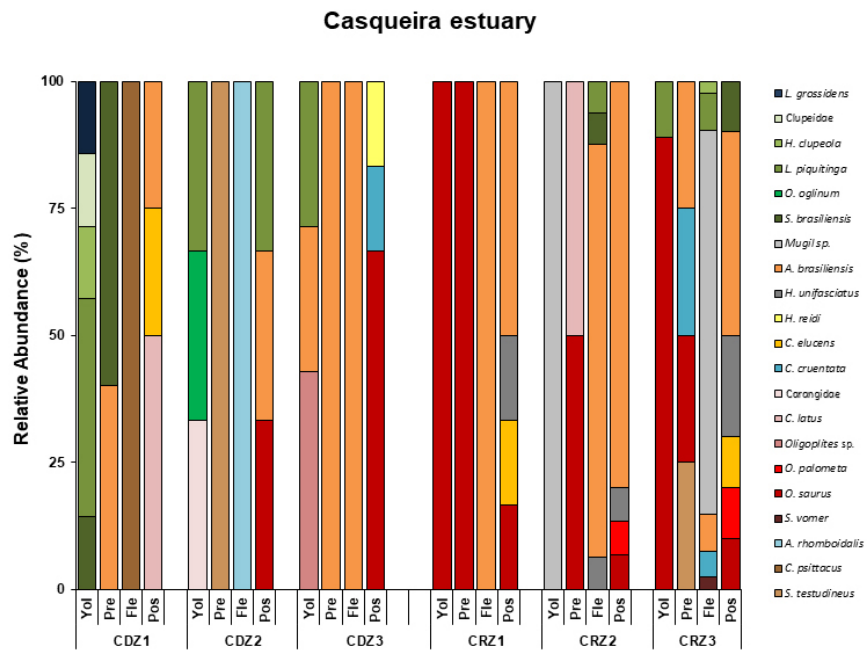
FIGURE 6 | Percentage contribution of species in Casqueira River estuary (Z1: Lower, Z2: Middle, Z3: Upper) zones in their periods of dry (CD) and rainy (CR). Yol = Vitelline larval; Pre = Preflexion; Fle = Flexion; Pos =